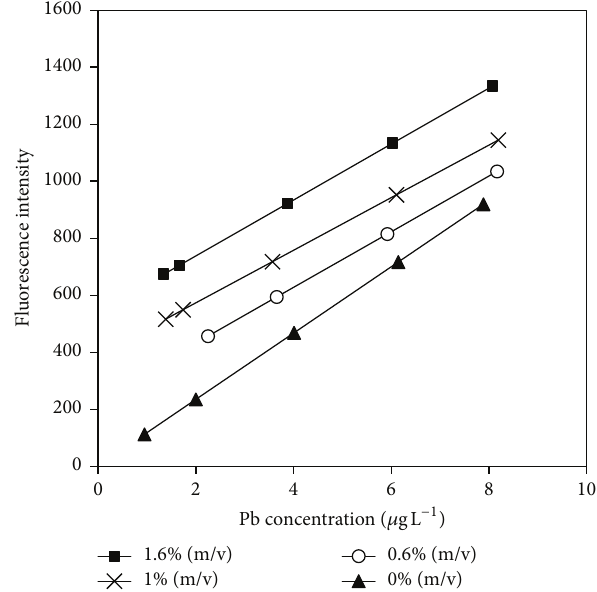
Figure 3: Calibration curves for lead obtained in the presence of different concentration of L-cysteine. Reaction conditions: 1% (m/v) KBH 4 , 1.5% (v/v) HCl, and 1.5% (m/v) K 3 [Fe(CN) 6 ].